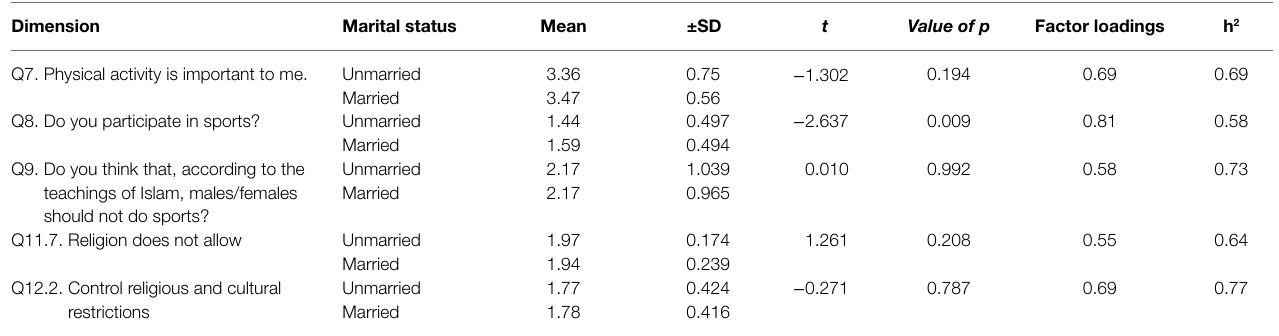
TABLE 4 | Sports participation item t -tests: Differences between unmarried and married participants with factor loadings and h 2 . Dimension Q7. Physical activity is important to me.